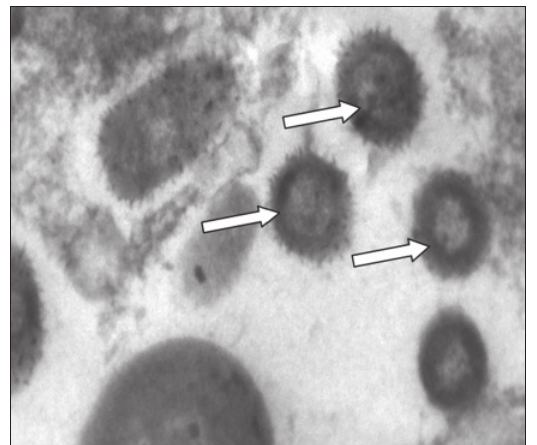
Figure-1: Arrows point to sheep poxviral particles visualized by transmission electron microscopy.